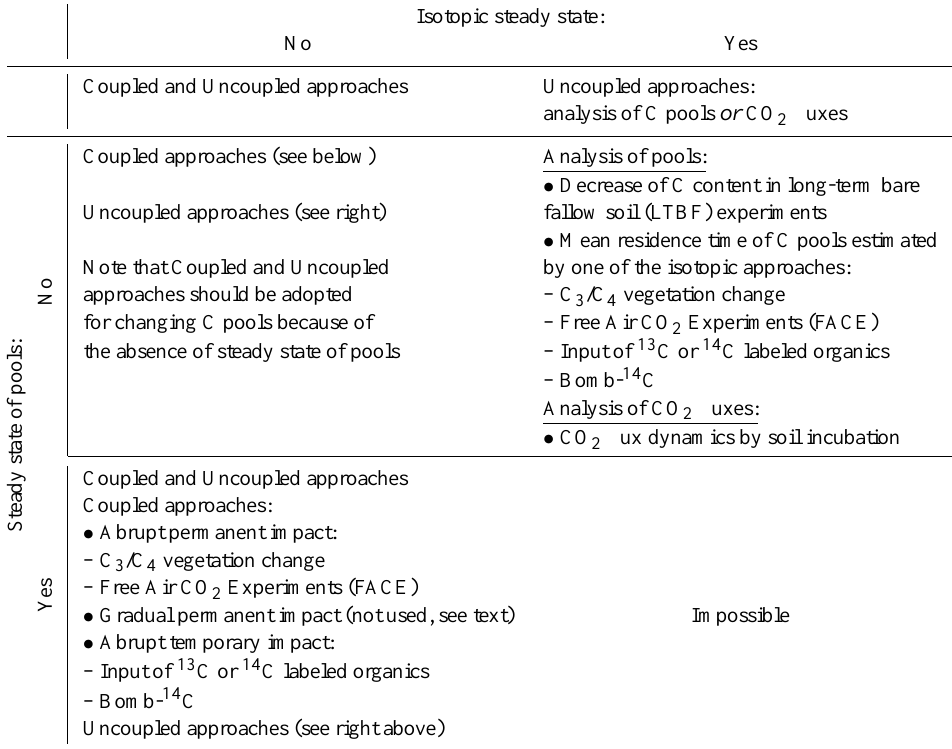
Table 1. Possibility to use uncoupled and coupled approaches for linking soil C pools with CO 2 fluxes and to study turnover processes depending on the presence of steady state of C pools and isotopic steady